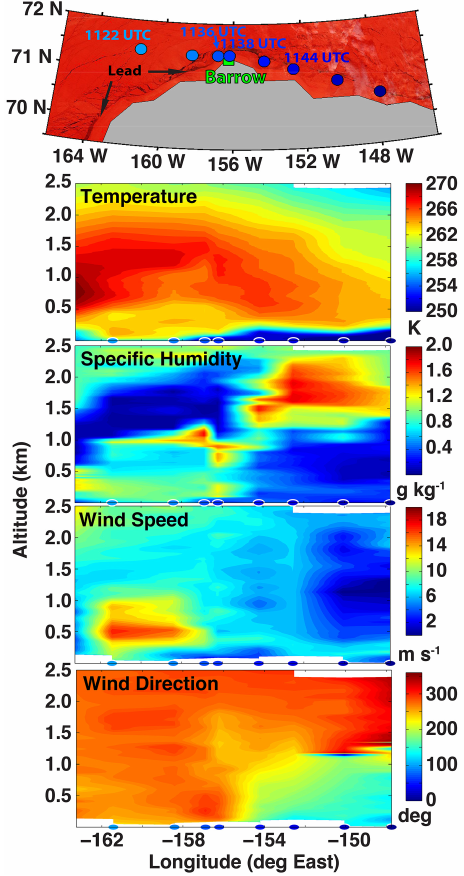
Figure 5. Upper panel: Global Hawk flight track on 10 March 2011 along Alaska’s north coast (see Figs. 2 and 3 for larger-scale con- text), with dropsonde locations and times (UTC) overlaid onto a MODIS satellite image (overpass time, 10:30UTC). Bands used for the image are band 3 (459–479nm), band 6 (1628–1652nm), and band 7 (2105–2155nm); resolution is 500m. Lower panels, from top to bottom: dropsonde cross sections of (a) temperature (K), (b) specific humidity (gkg − 1 ) , (c) wind speed (ms − 1 ) , and (d) wind direction (deg). Dropsonde locations are marked with blue dots, as in the top panel, and match the colors used in Fig.